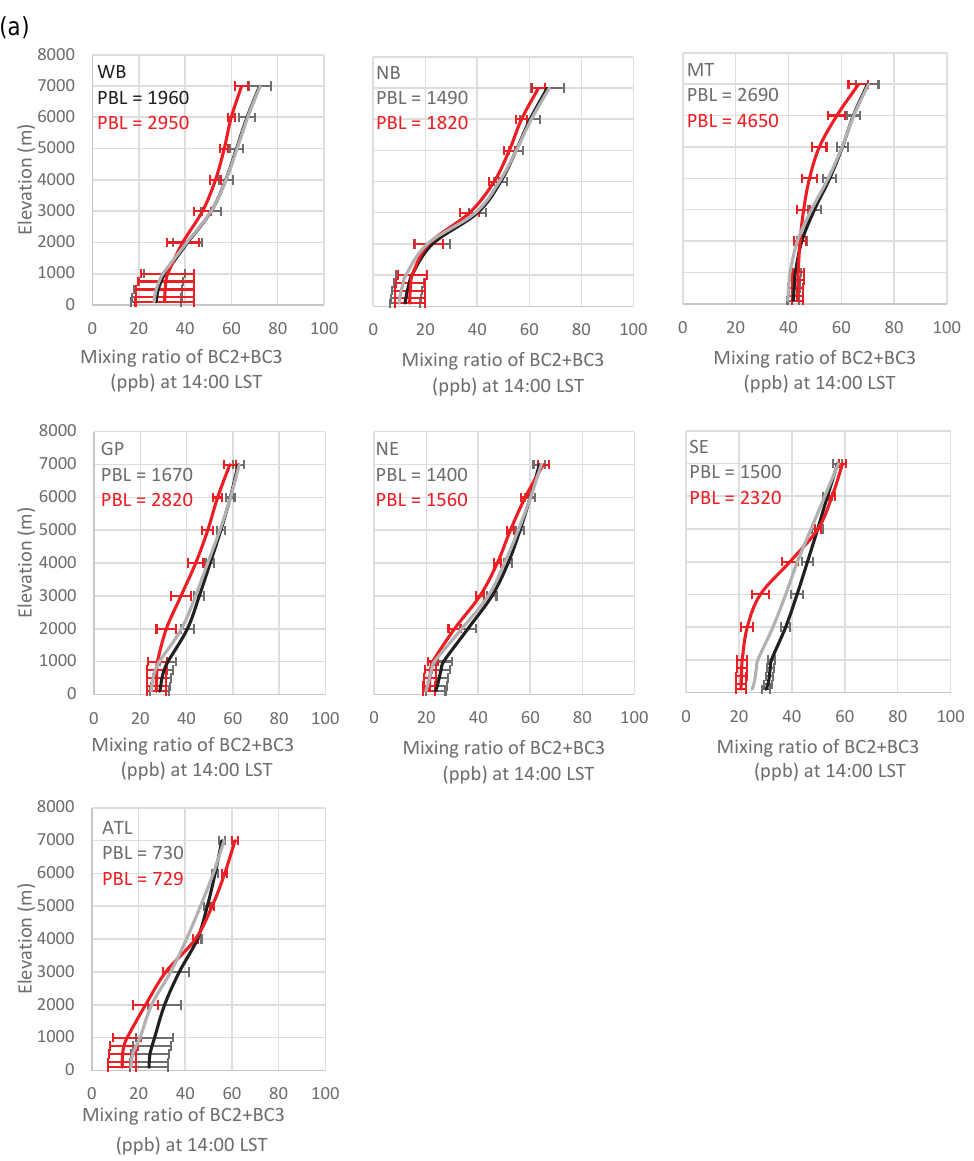
treatment in CTMs serves as an important source of uncer- tainty when estimating the impact of LB ozone on ozone level at the surface aside from the meteorological inputs and the lateral boundary conditions. Differences in DM8A O 3 and DM8A BCT between WRF / CMAQ and WRF / CAMx show strong spatial correlations with similar magnitudes ex- cept for summer (Fig. 7b). Two processes lead to weaker agreement between the difference in inert tracers and the dif- ference in ozone in summer. First, chemical decay due to the photolysis of LB ozone is the strongest in summer and not represented by inert tracers. Second, the chemical formation of ozone peaks in summer. The results suggest that the im-